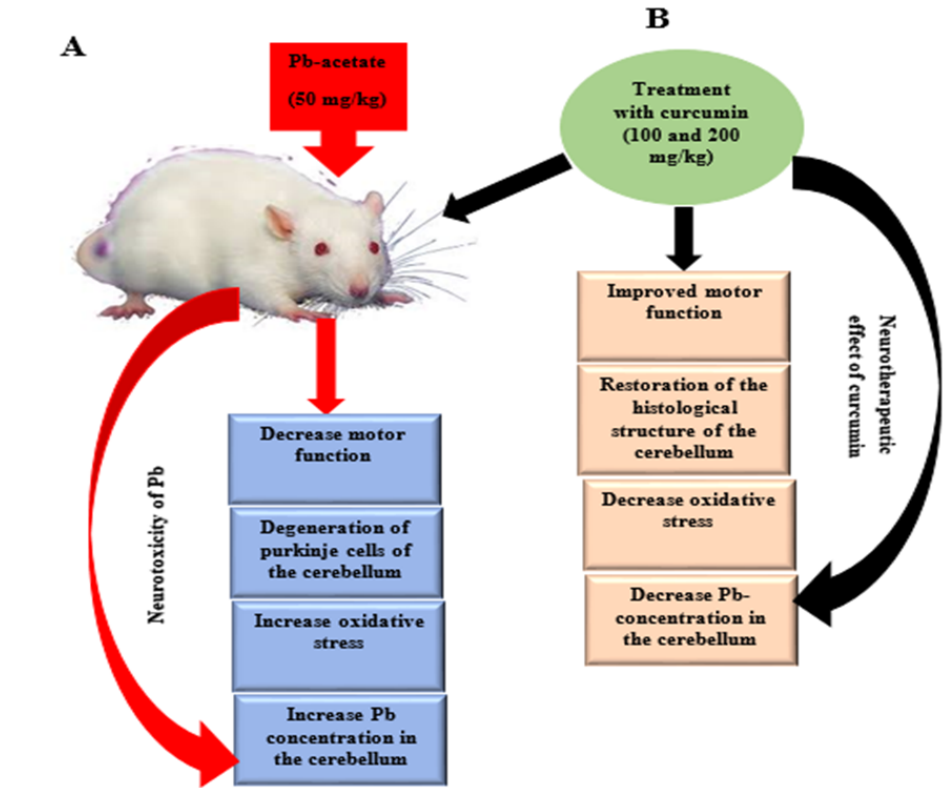
Figure 18. Proposed mechanism of Pb-induced cerebellar toxicity and the ameliorative e ff ects of curcumin. Pb induction in rats, results in decreased motor function, degeneration of Purkinje cells of the cerebellum, increased oxidative stress, and increased Pb concentration in the cerebellum. Curcumin administration ameliorates the above-mentioned aberrations, which supports the neurotherapeutic e ff ects of